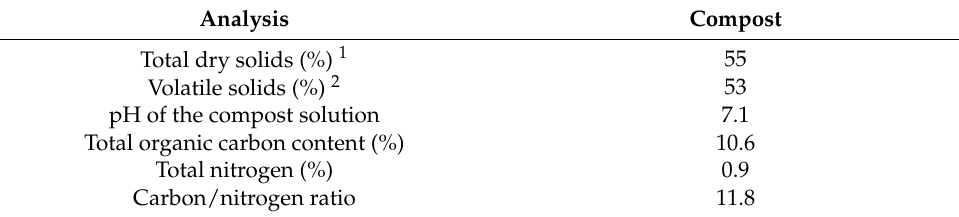
Table 1. Properties of the controlled